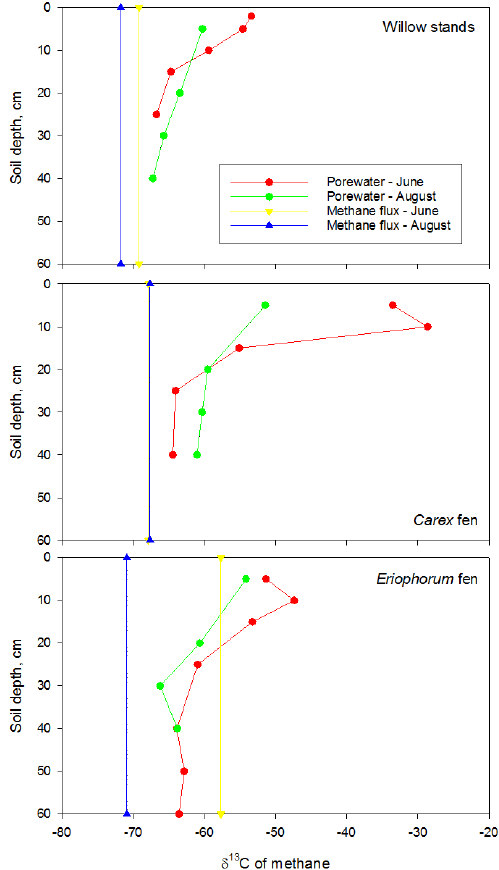
Figure 6. Mean and standard deviations in δ 13 C of emitted CH 4 (red) and of CH 4 contained in porewater samples collected from 5cm (green) and 30cm depths (yellow) of wetlands at the Seida site during 2007 and 2008 growing seasons from (a) willow stands, (b) Carex fens and (c) Eriophorum fens.